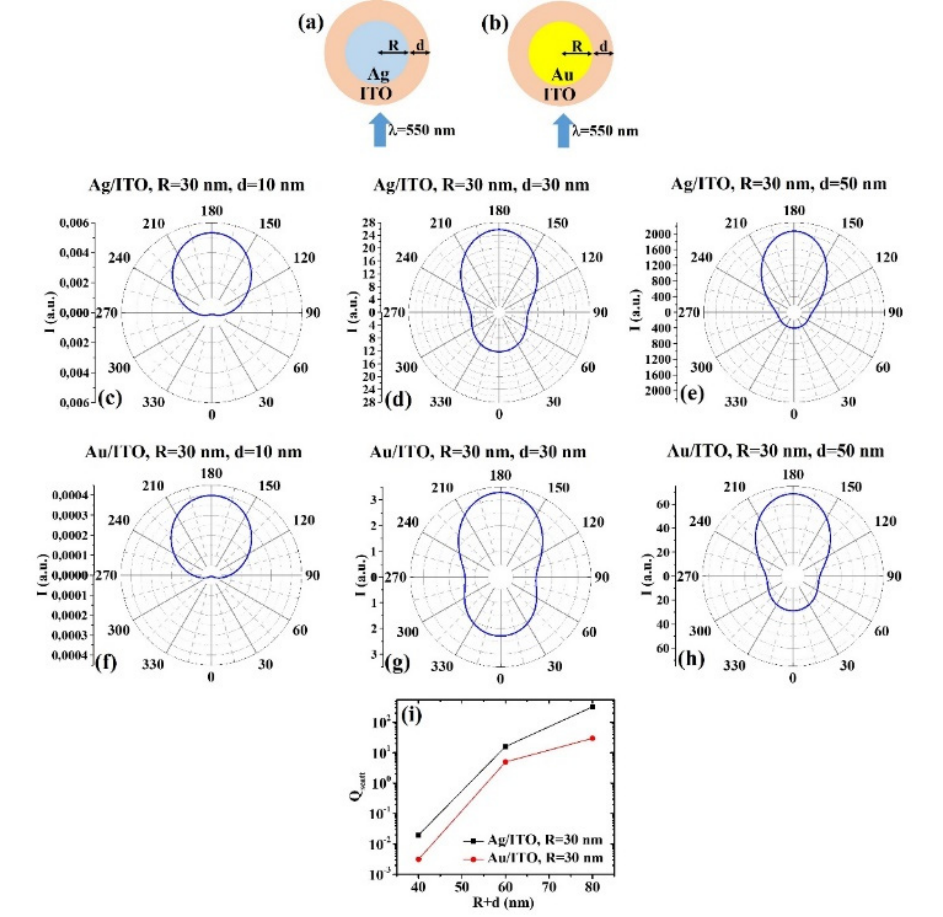
Figure 5. ( a , b ) Scheme of the structure of the simulated Ag/ITO ( a ) and Au/ITO ( b ) core–shell spherical particle with core radius R and shell width d and electromagnetic radiation of wavelength λ = 550 nm impinging on the particle from 0 ◦ . ( c – e ) Calculated polar diagrams for the intensity of the scattered light from the Ag/ITO core–shell spherical particle fixing the Ag core radius R to 30 nm and increasing the ITO shell width from 10 nm to 50 nm. ( f – h ) Calculated polar diagrams for the intensity of the scattered light from the Au/ITO core–shell spherical particle fixing the Au core radius R to 30 nm and increasing the ITO shell width from 10 nm to 50 nm. ( i ) Calculated scattering efficiency for the light (wavelength λ = 550 nm) scattering process of the Ag/ITO (black dots) and Au/ITO (red dots) core–shell spherical particles fixing the core radius to R = 30 nm and increasing the ITO shell width d from 10 nm to 50 nm.